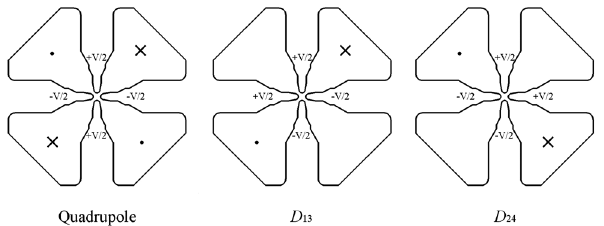
FIG. 9. Diagrams of the magnetic field for the quadrupole and dipoles of a four-vane